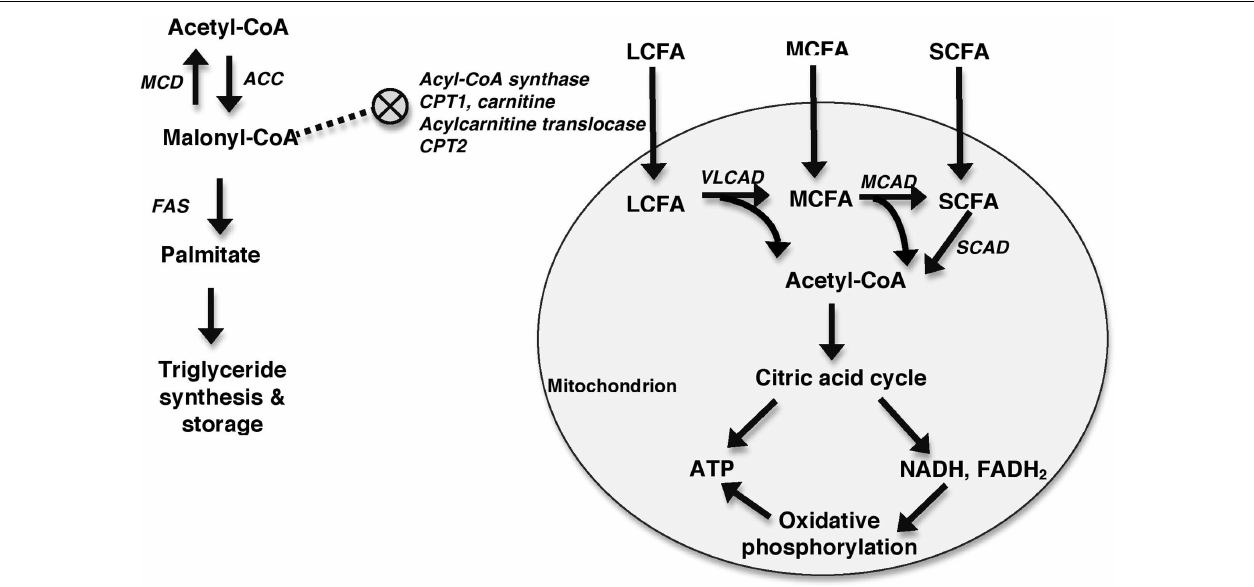
FIGURE 4 | Generalized schematic depicting mitochondrial FAO . Fatty acids enter the mitochondria with MCFAs and SCFAs diffusing in and LCFAs requiring the assistance of a number of molecules including acyl-CoA synthase, CPT1, carnitine, acylcarnitine translocase, and CPT2 to enter the mitochondria. This process is inhibited by malonyl-CoA, which inhibits CPT1. Malonyl-CoA is primarily formed from acetyl-CoA in a reaction catalyzed by acetyl-CoA carboxylase (ACC). Malonyl-CoA can be metabolized back into acetyl-CoA by MCD. The roles of malonyl-CoA include the synthesis and elongation of fatty acids in reactions catalyzed by fatty acid synthase (FAS), and the inhibition of CPT1. Once within the mitochondria, fatty acids undergo (cid:12) -oxidation to form acetyl-CoA. VLCAD oxidizes LCFAs, MCAD oxidizes MCFAs, and short-chain acyl-CoA dehydrogenase (SCAD) oxidizes SCFA. Acetyl-CoA is then shuttled into the citric acid cycle for production of ATP and reducing coenzymes, such as NADH and FADH 2 . These reducing coenzymes can then be utilized in oxidative phosphorylation to produce additional ATP.